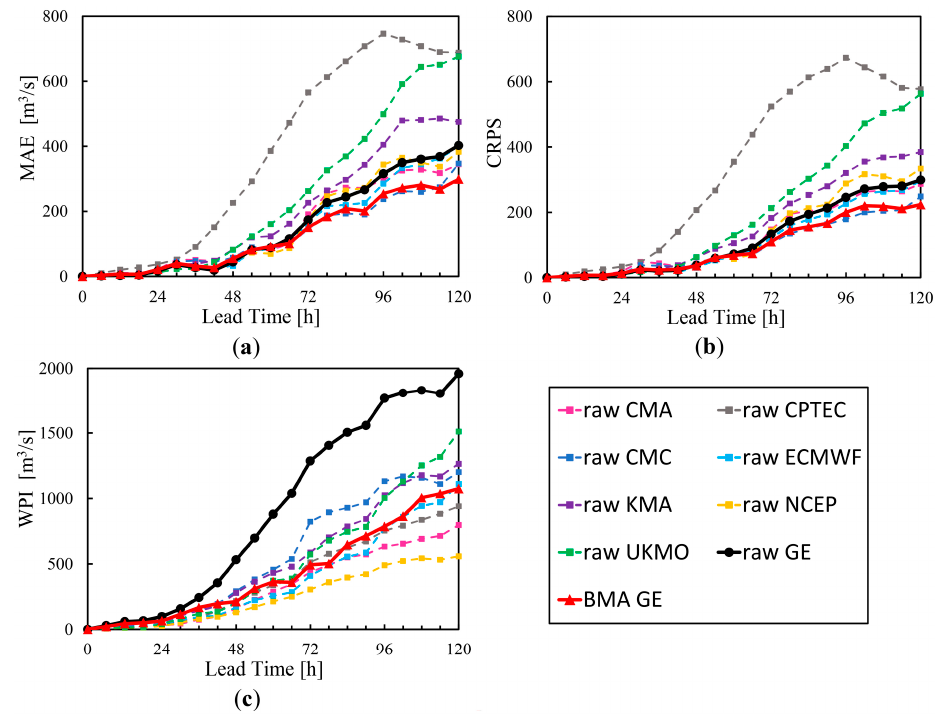
Figure 5. Comparison of calibration and sharpness between BMA GE, raw GE, and raw SE forecasts: ( a ) mean MAE over the verification period; ( b ) mean CRPS over the verification period; ( c ) mean WPI over the verification period.